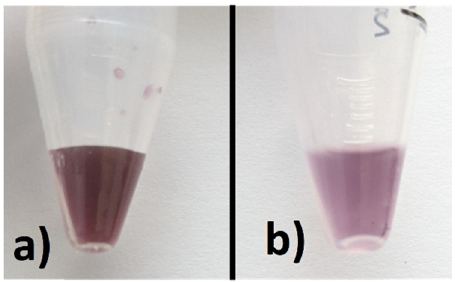
Figure 10: ( a ) Unconjugated AuNPs, and ( b ) AuNPs conjugated with SARS - CoV - 2 and